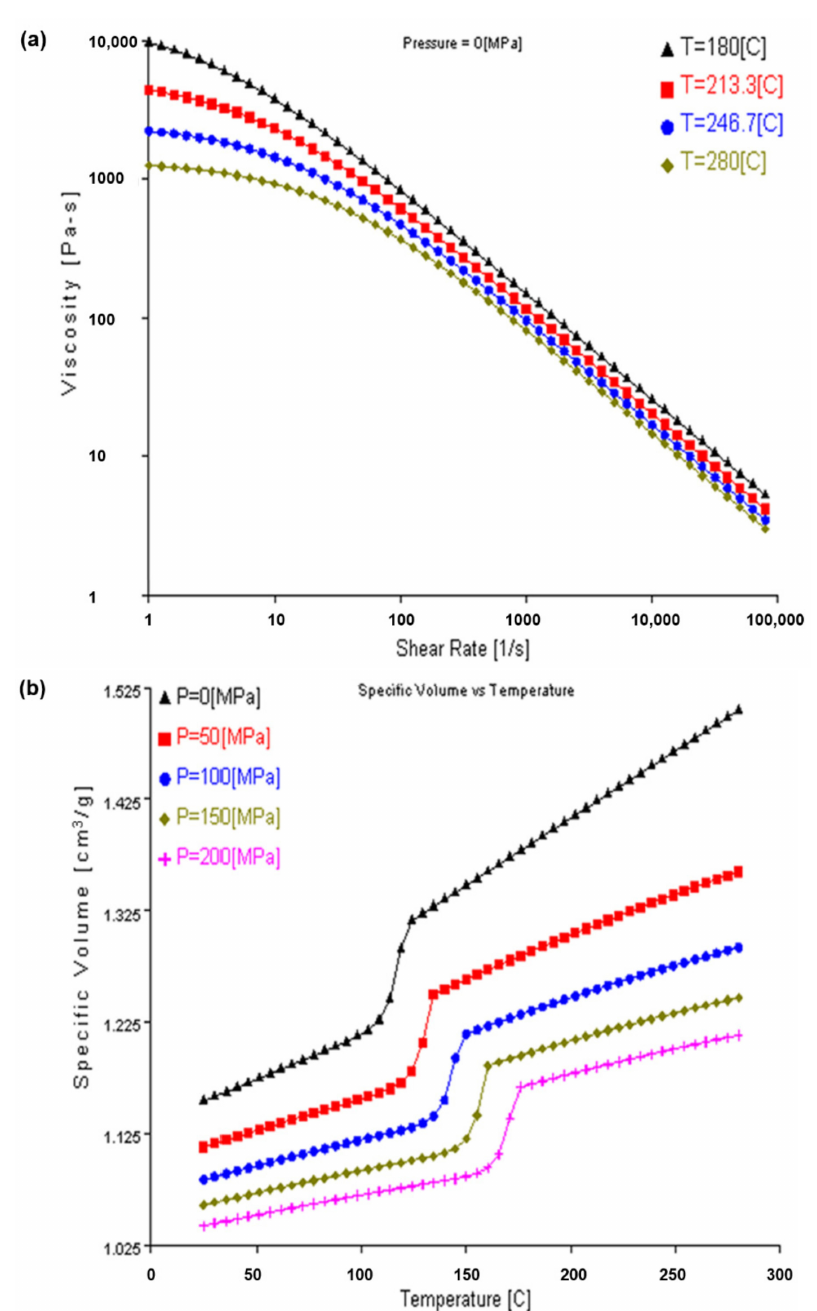
Figure 9. Viscosity—shear rate relationship ( a ) and p-v-T diagrams ( b